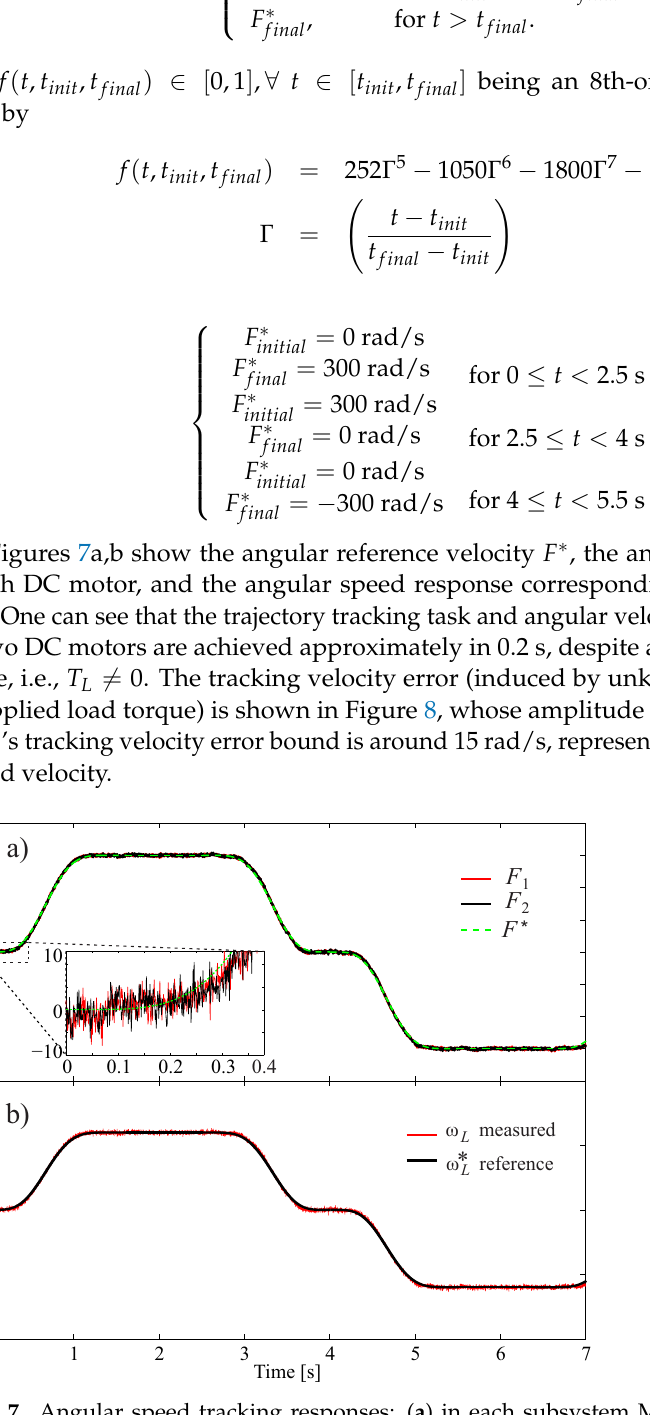
Figure 7. Angular speed tracking responses: ( a ) in each subsystem M1 and M2, and ( b ) in the common stiff